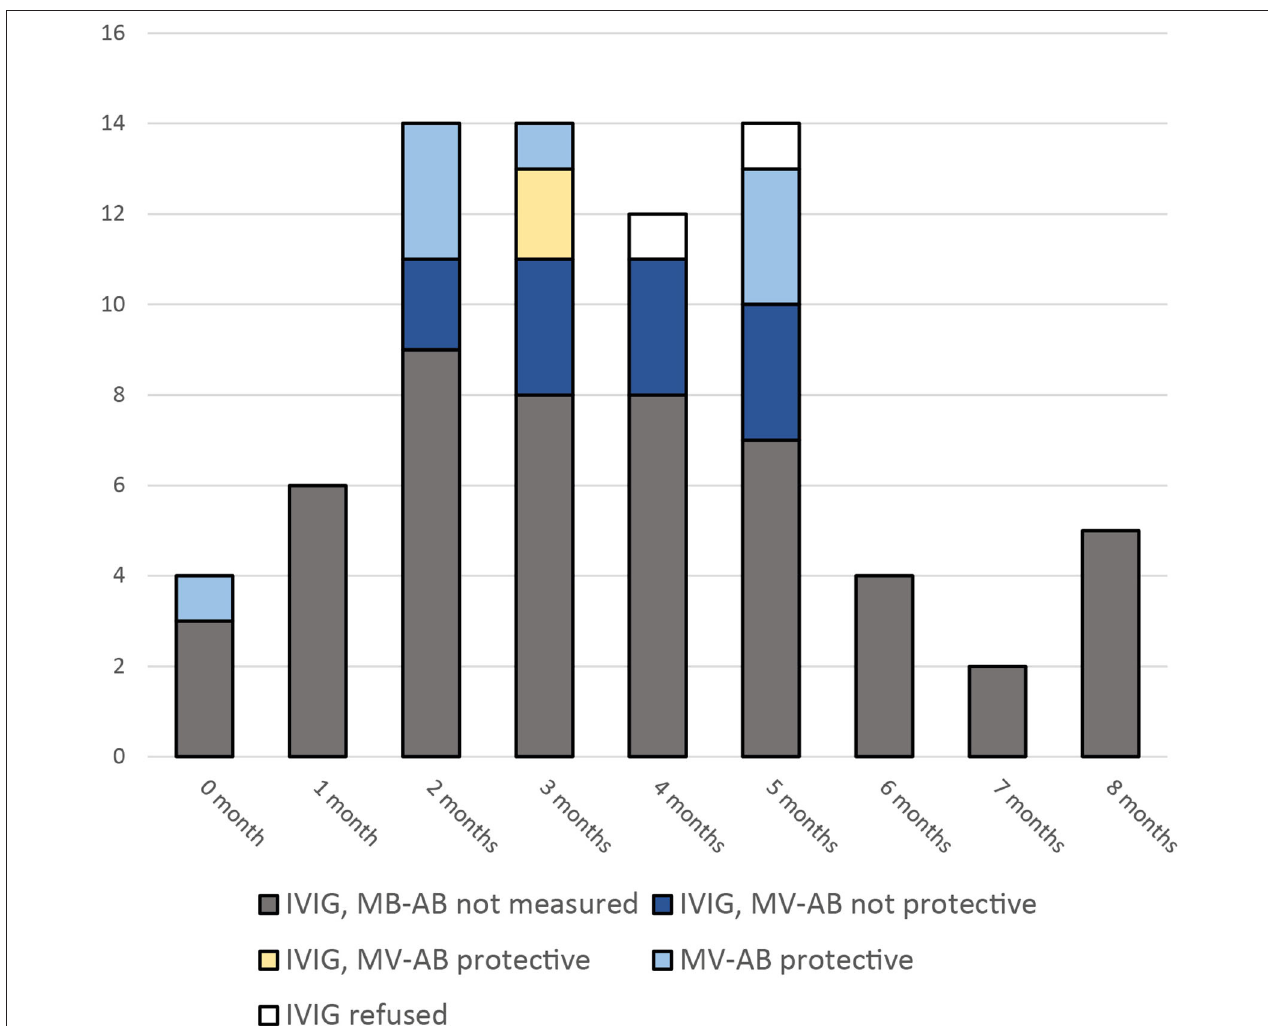
FIGURE 1 | Infants eligible for PEP with IVIG after exposure to a measles patient. Measles virus specific antibodies (MV-AB) above 16.5 IU/ml were assumed to be protective. (Measured with LIAISON ® Measles IgG).